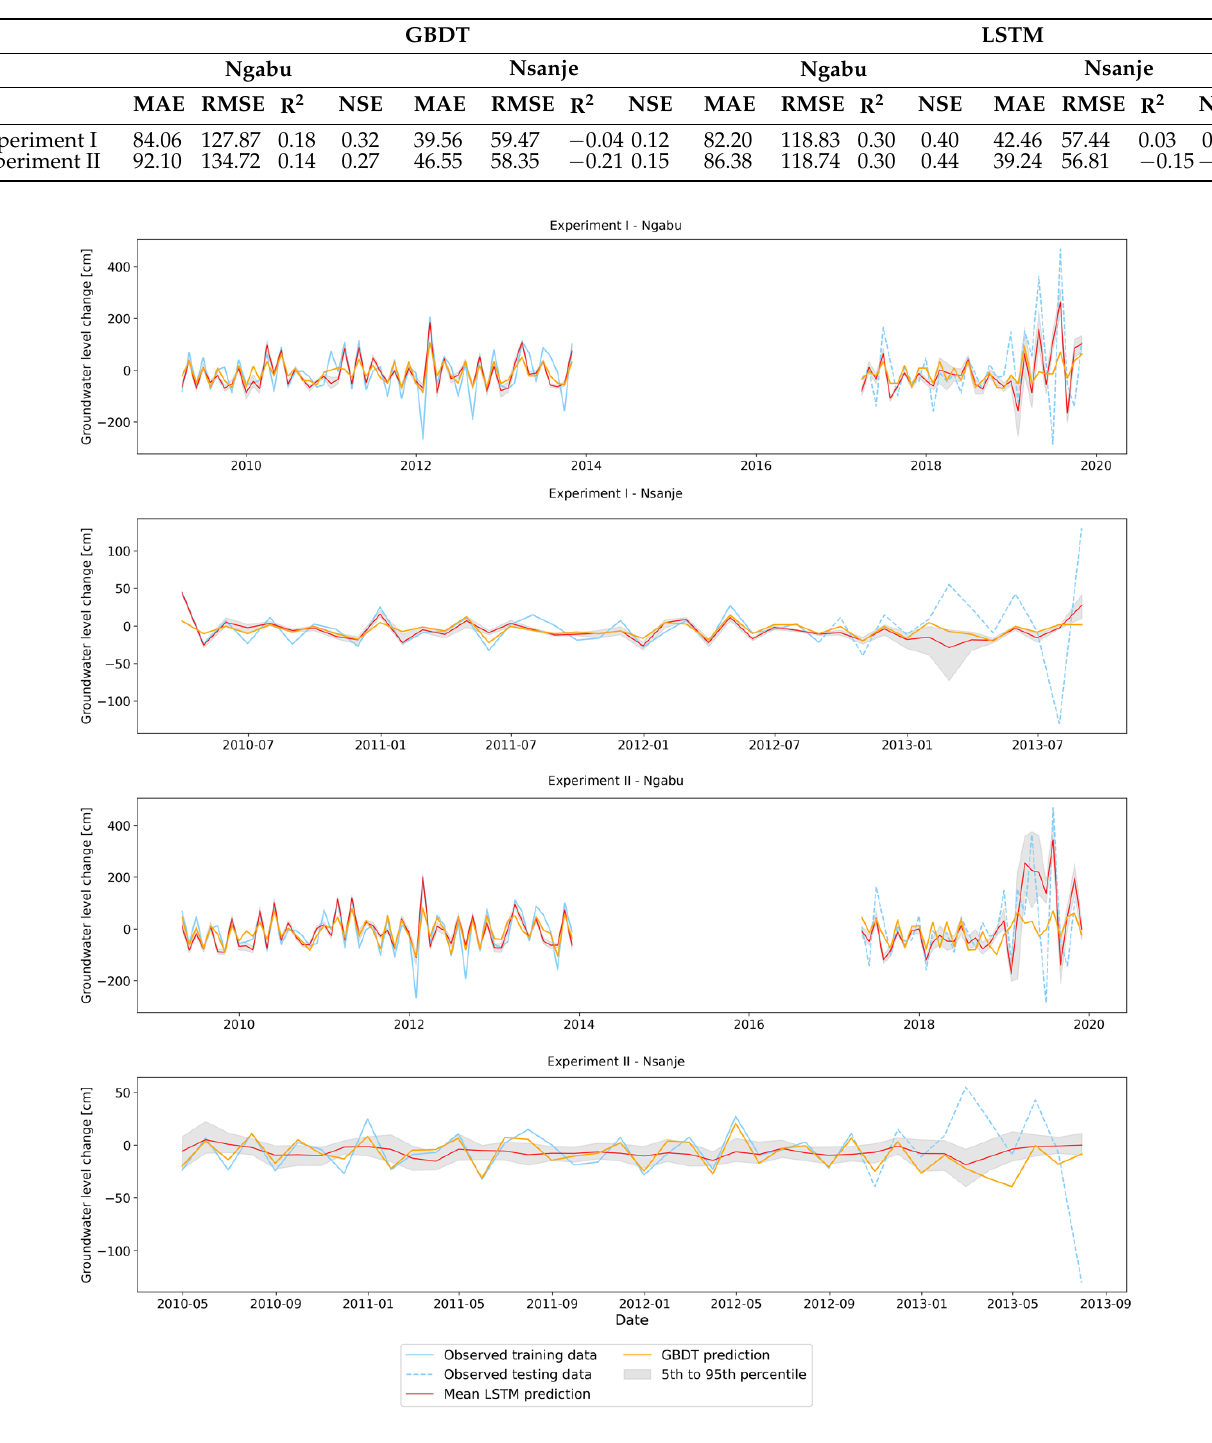
Table 8. Comparison errors scores between the GBDT and LSTM model on the test set for all the experiments.